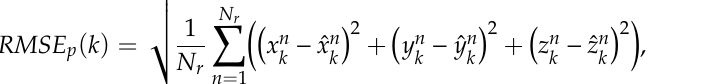
Table 1. The initial positions and velocities of target and observation platforms.